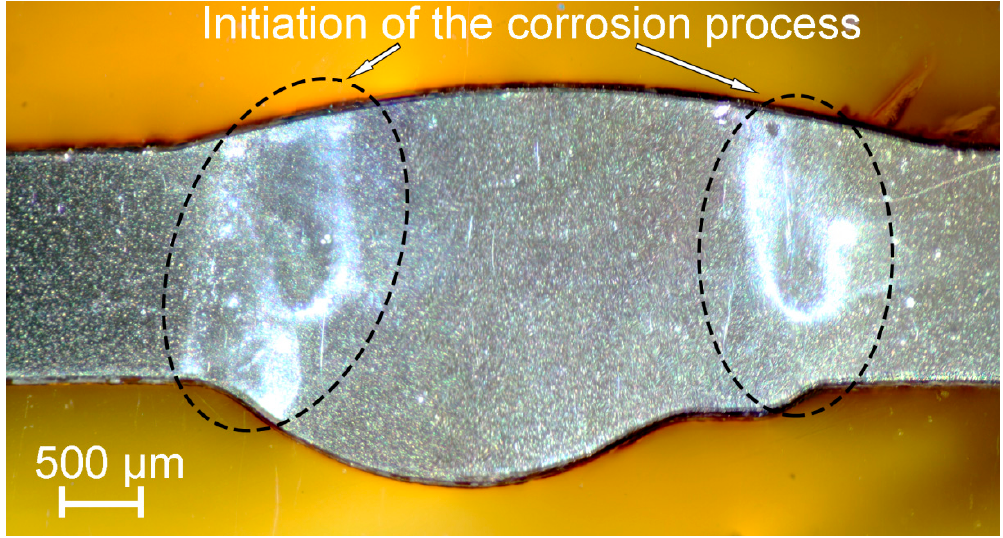
Figure 8. Optical image of the sample after 1.5 h immersion in 3% NaCl. Initiation of the corrosion was detected in the HAZ.